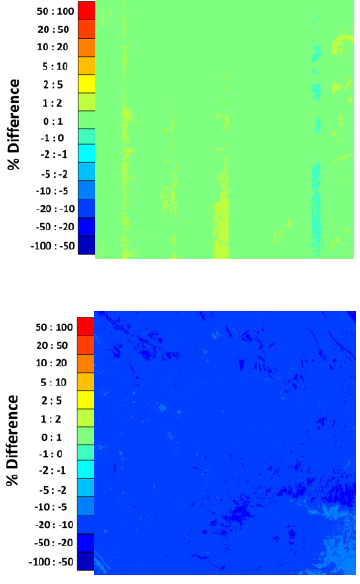
Figure 6. Relative difference at 550 nm of the surface reflectance values obtained from the CHRIS@CRI atmospheric correction algorithm with GEOS-Chem model and those obtained with AERONET data, used as reference. The